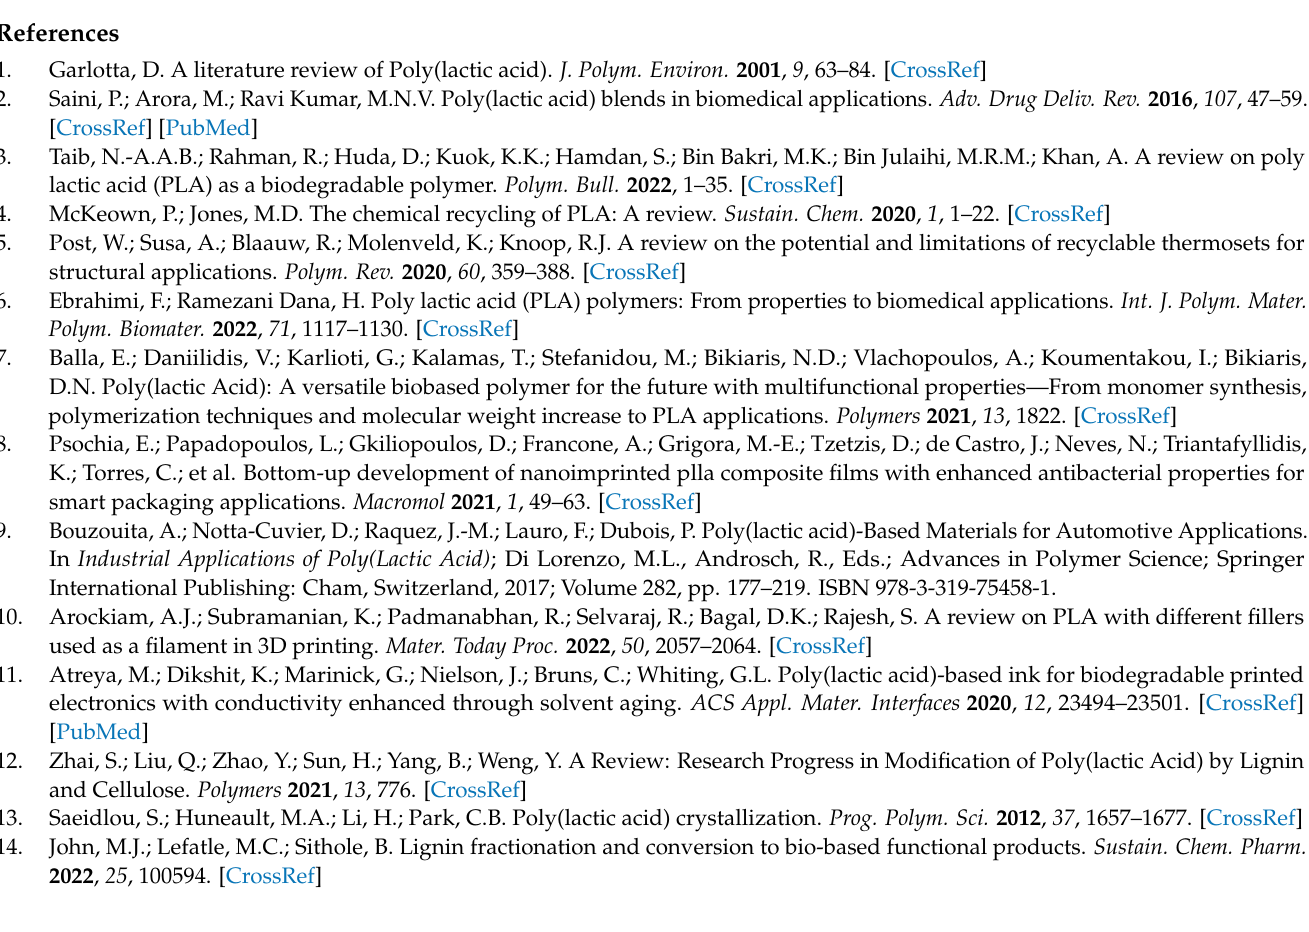
nanolignin. Figure S3: Tensile stress-strain curves of PLA-L composites. Figure S4: Tensile stress- strain curves of PLA-NL composites. Figure S5: SEM images of PLA-L/NL composites containing different L/NL content. Figure S6: Qualitative antioxidant capacity of composites—Photographs of DPPH/ethanol solution for different PLA-Lignin (a) and PLA-Nanolignin (b) composites after 24 h exposure to PLA-L/NL